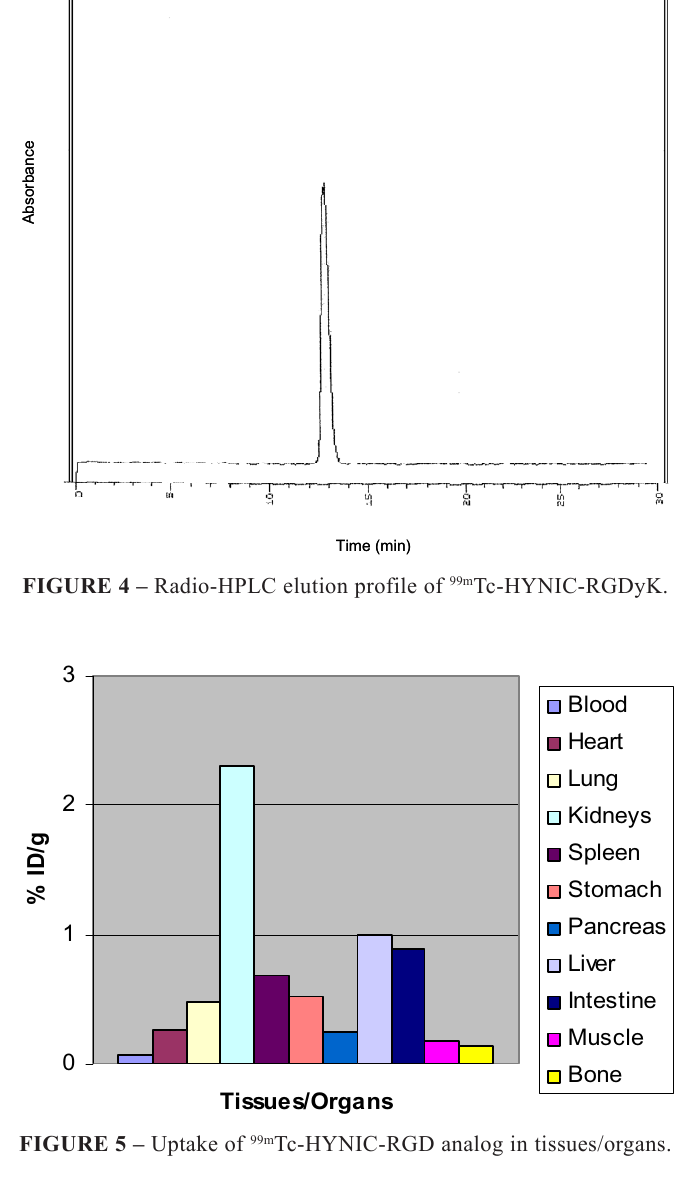
TABLE 1 – Uptake of 99mTc-HYNIC-RGD in